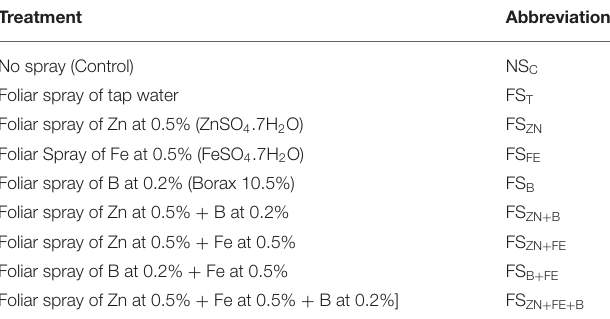
TABLE 1 | Treatment description and abbreviation